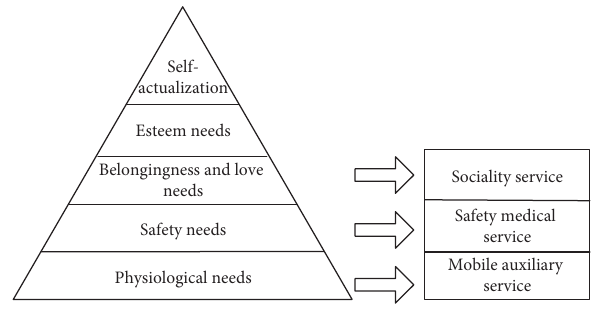
Figure 1: Map between needs and service.